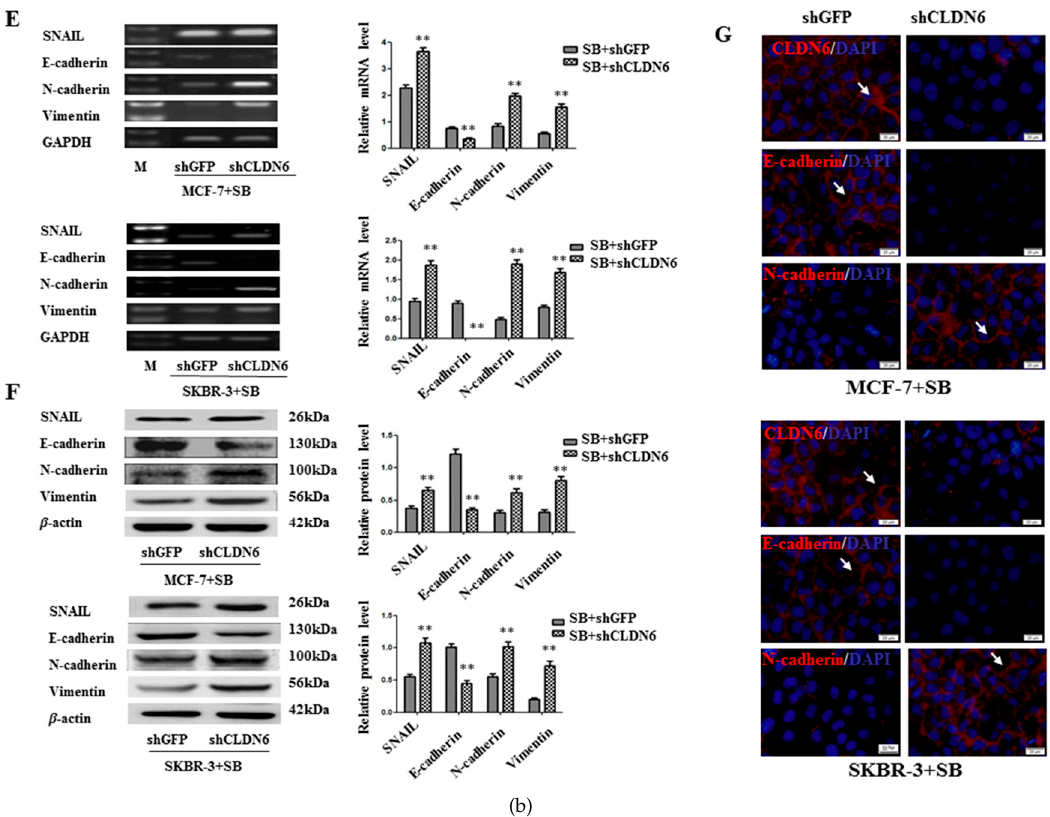
Figure 4. CLDN6 was required to inhibit EMT and tumor migration and invasion. Cells were stimulated with 10 µM SB431542 for 24 h. ( A ) RT-PCR and immunoblot expression analyses of CLDN6 in MCF-7-shGFP, MCF-7-shCLDN6, SKBR-3-shGFP, and SKBR-3-shCLDN6 cells, and densitometric analysis of relative expression levels after normalization to loading control GAPDH or β -actin are presented. ( B ) The effect of knocking down CLDN6 on cell morphology of SB431542 treated MCF-7 and SKBR-3 cells (bar, 100 µm). ( C ) Representative light microscope images of wound-healing assays for MCF-7 and SKBR-3 cells treated with SB431542 to evaluate the impact of CLDN6 on their migration rate into the cell-free area (bar, 200 µm). ( D ) Matrigel invasion assay. Cells that invaded the Matrigel were stained with Giemsa and counted. All results are presented as the average of cells counted in 10 fields per condition (bar, 50 µm). Results of: ( E ) RT-PCR; and ( F ) Western blotting analyses to determine the impact of CLDN6 on the expression of EMT-related genes (SNAIL, E-cadherin, N-cadherin, and vimentin) in MCF-7and SKBR-3 cells treated with SB431542, and densitometric analysis of relative gene expression levels after normalization to the loading control GAPDH or β -actin are presented. ( G ) Immunofluorescence analysis to evaluate the impact of CLDN6 on the expression levels of EMT markers in MCF-7 and SKBR-3 cells treated with SB431542. Representative immunofluorescence images (200×) generated using anti-E-cadherin, anti-N-cadherin, and CLDN6 primary and FITC-conjugated secondary antibodies in the breast cancer cells. Blue, cell nuclei were stained with 4,6-diamidino-2-phenylindole. Localization of E-cadherin, N-cadherin, and CLDN6 (red) at the cell–cell junctions is indicated by white arrows (bar, 20 µm). ** p < 0.01. Bars represent mean ± SE ( n = 3).